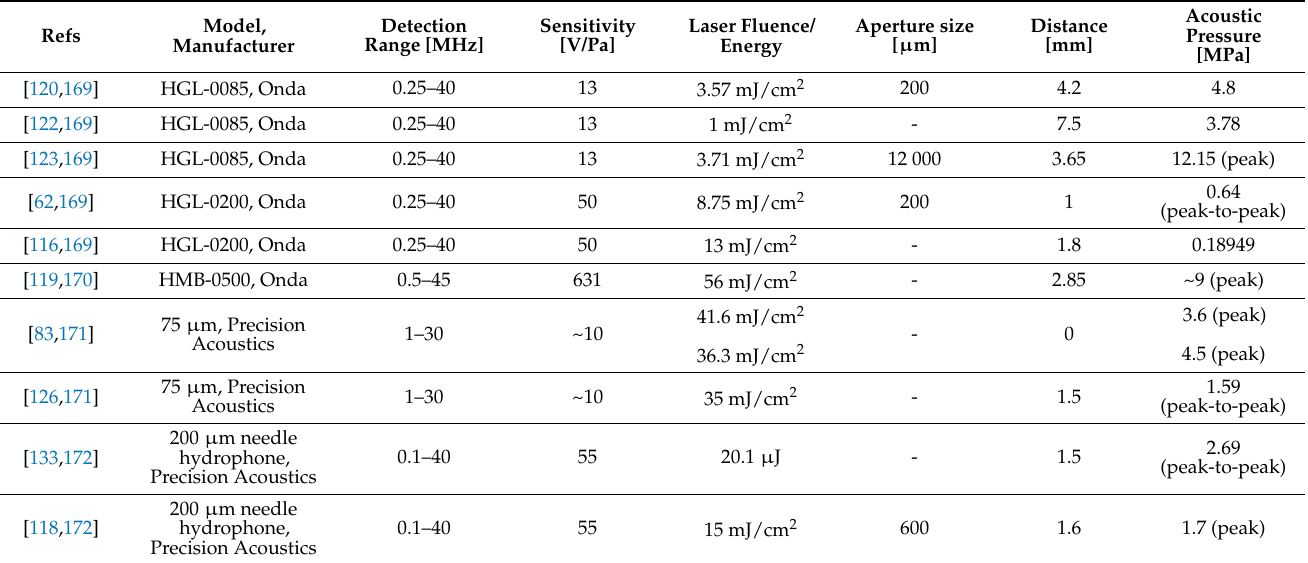
Table 2. PVDF membrane hydrophones employed in photoacoustic systems.